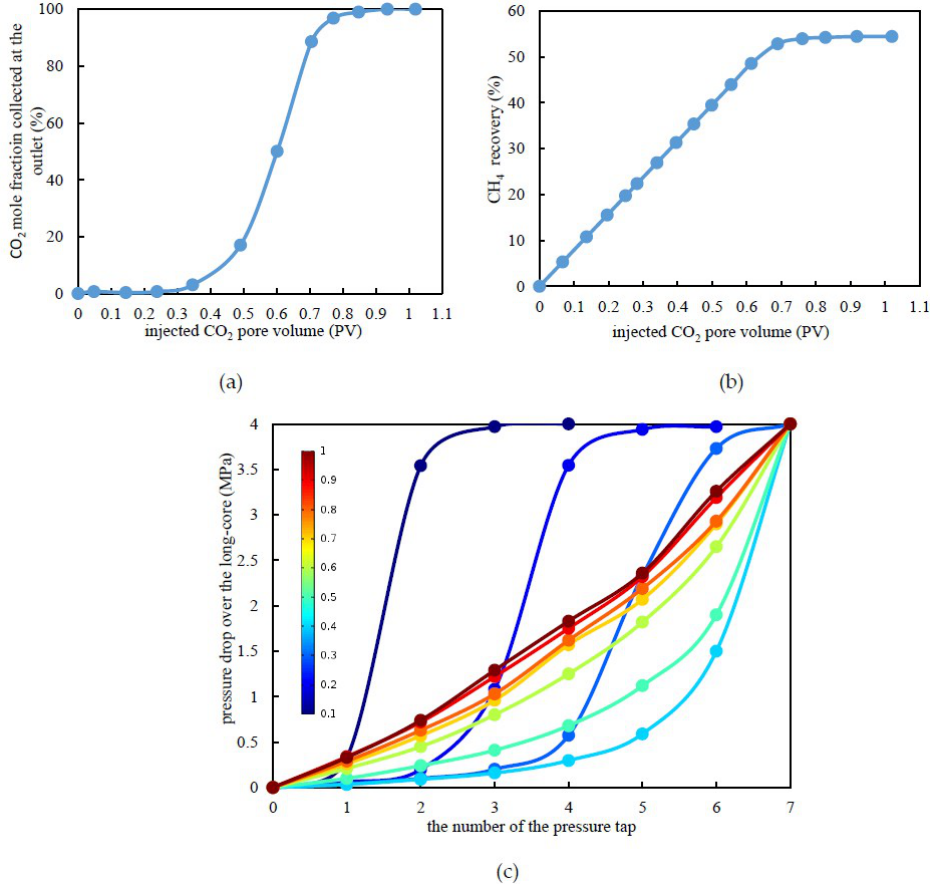
Figure 2. Experimental results under constant differential pressure displacement. ( a ) CO 2 mole fraction at the outlet versus the injected CO 2 pore volume. ( b ) CH 4 recovery by CO 2 flooding. ( c ) Pressure drop over a tight long-core versus the pore volume during CO 2 flooding (Note: the colored lines represent the various injected CO 2 pore volumes).